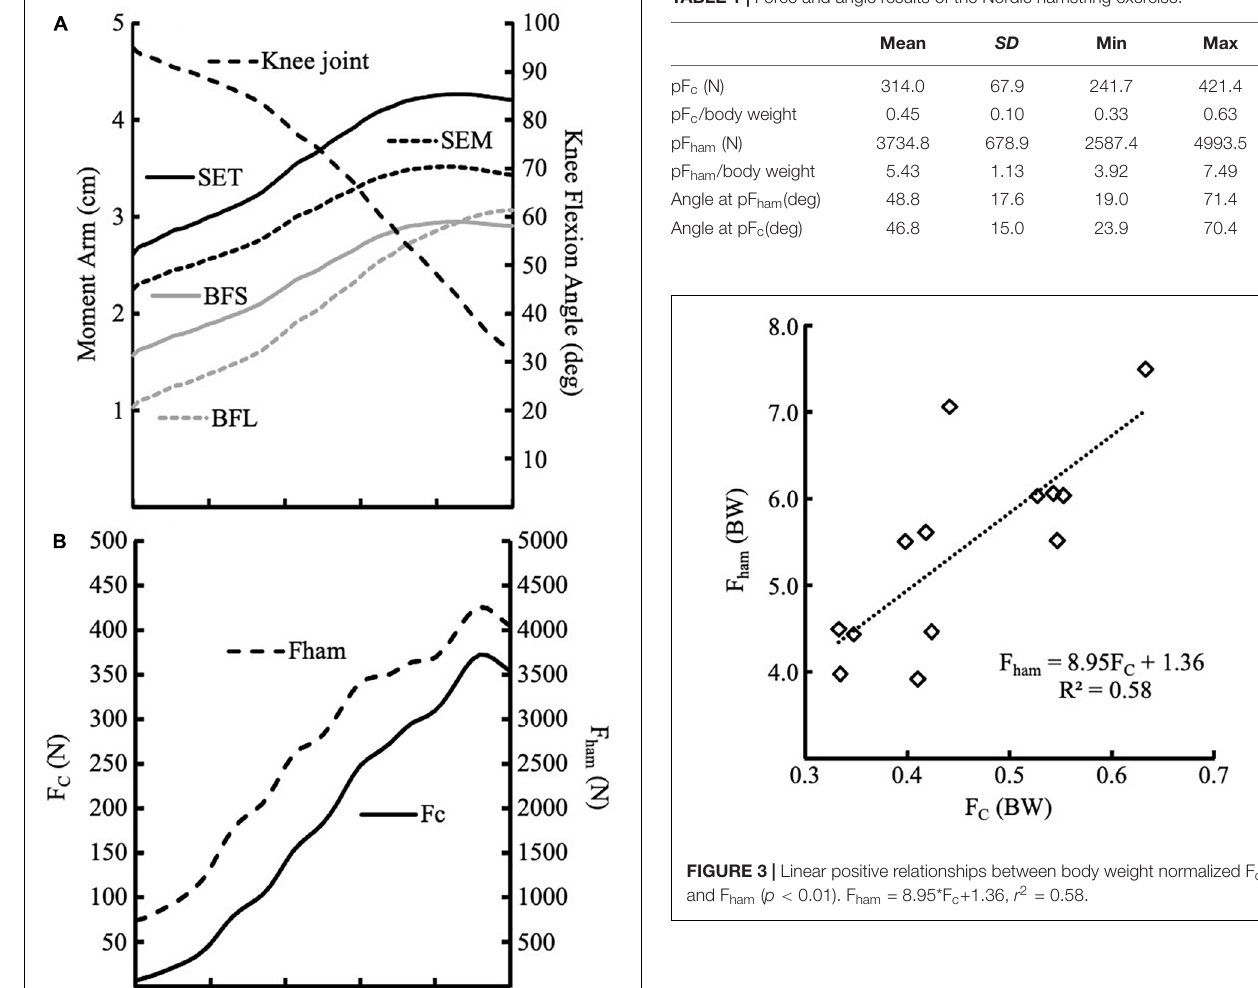
ankle contact force at hook is not equal or linear to the hamstring force. Actually, the moment generated by the